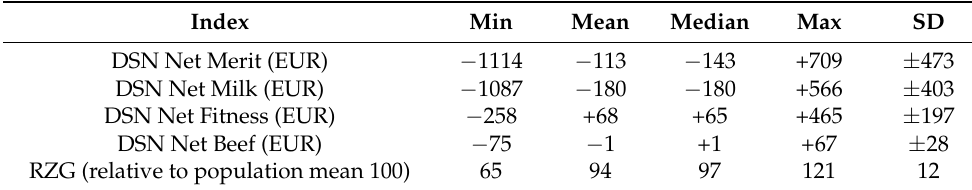
Table 2. Summary of 33 DSN sires for DSN Net Merit, DSN Net Milk, DSN Net Fitness, and DSN Net Beef for a cow’s lifetime, and RZG on a relative scale (population mean 100). Basic data originate from the breeding evaluation in August